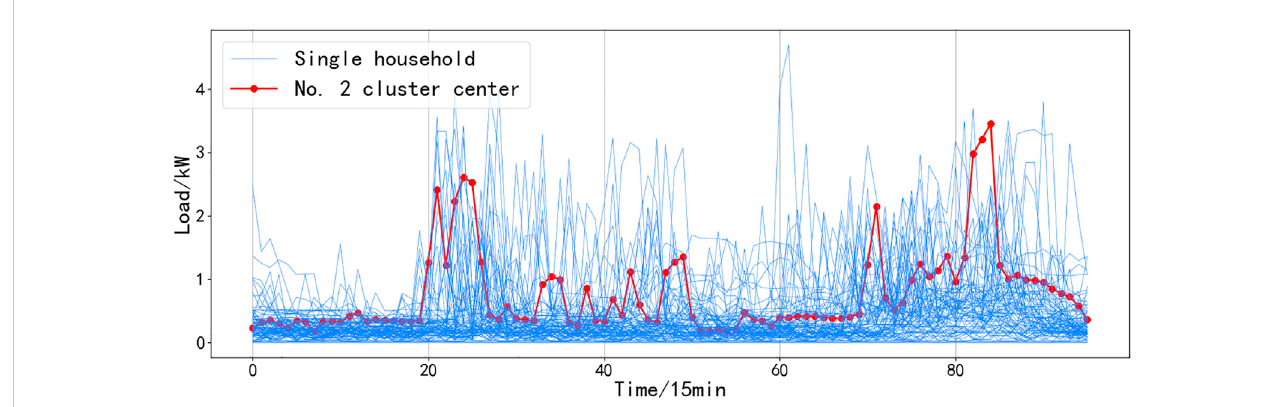
FIGURE 5 Category 1 of residential electricity mode and the clustering center of it.